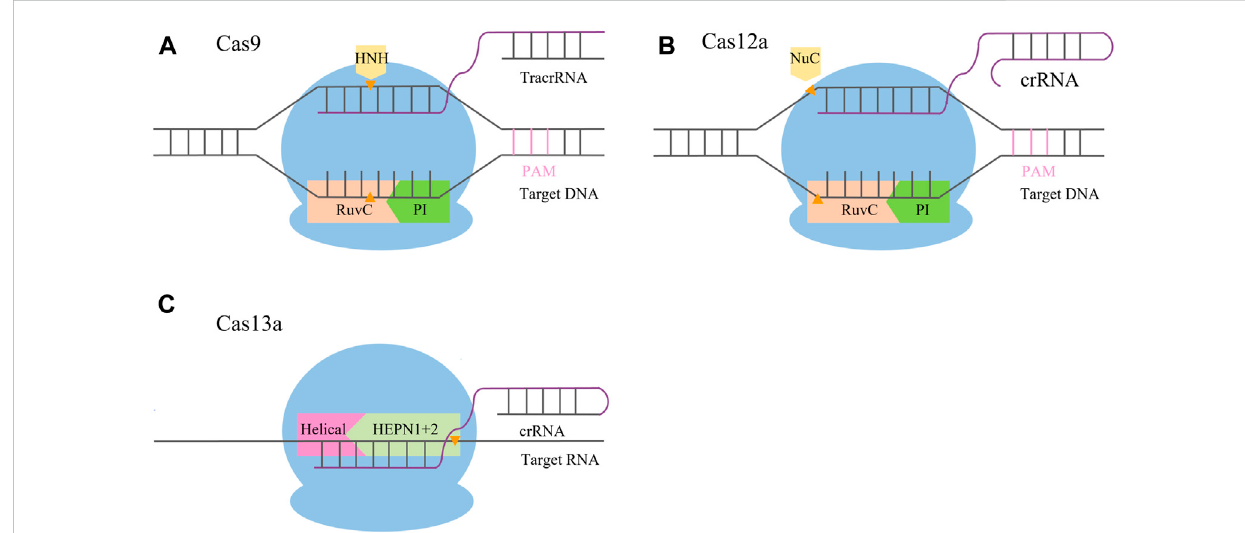
FIGURE 1 SchematiccomparisonofCRISPR/Cassystems. (A) CRISPR/Cas9systemmediatesitsfunction via Cas9andtwoRNAs,thecrRNAandtracrRNA.After hybridization, the crRNA/tracrRNA complex associates with the Cas9 nuclease and binds to its recognition site upstream of the PAM sequence. Recognition of the crRNA/tracrRNA/target complex is mediated by the REC (recognition) lobe; the PI (PAM interacting) domain is in charge of PAM recognition. The DSB is mediated by the HNH (orange) and RuvC nuclease domains (pink), with the HNH domain cleaving the target and the RuvC domain cleaving the non-target strand. (B) CRISPR/Cas12a system mediates its function via Cas12a and a single crRNA. After hybridization, the complex bindstoitsrecognitionsitedownstreamofthePAMsequence.RecognitionofthecrRNA/targetcomplexismediatedbytheREC(recognition)lobe;thePI (PAMinteracting,green)domainisinchargeofPAMrecognition.TheDSBismediatedbytheNuc(orange)andRuvCdomains(pink),withtheNucdomain cleaving the target strand and the RuvC domain cleaving the non-target strand. (C) CRISPR/Cas13 system mediates its function via Cas13 and a single crRNA. After hybridization, the complex binds to its recognition site within the target RNA mediated by the guide sequence of the crRNA. Recognition of the crRNA/target complex is mediated by the REC (recognition) lobe; the target RNA is cleaved by the HEPN domain (light